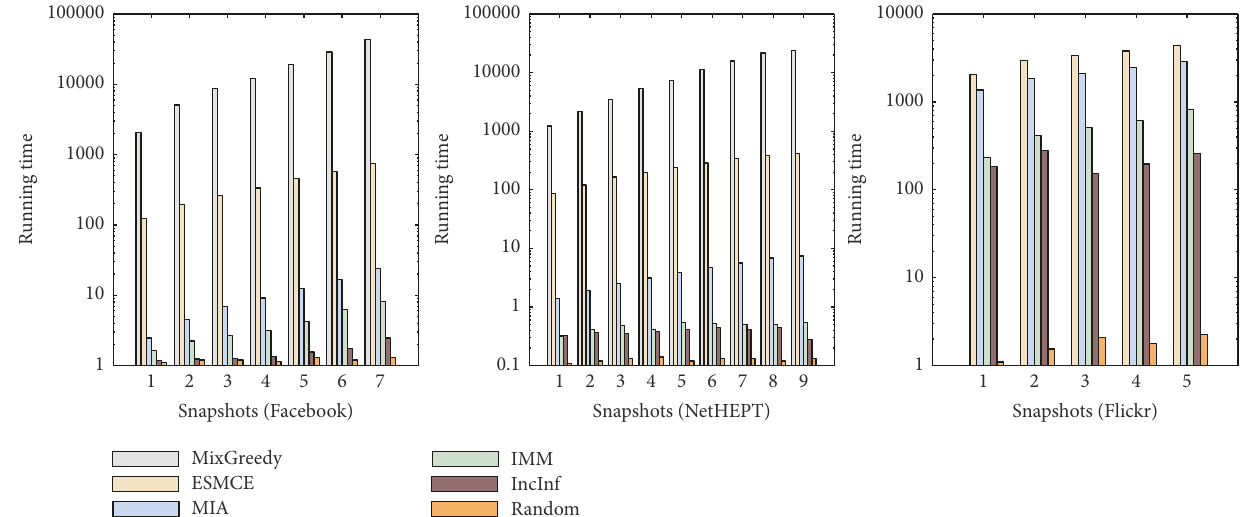
Figure 5: The time costs of different algorithms on three real-world